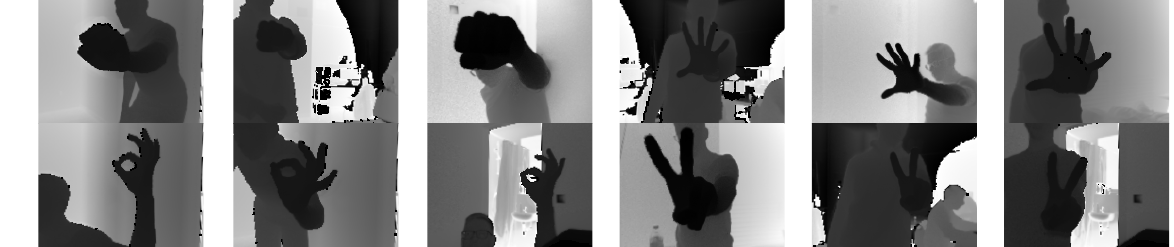
Figure 4. Depth images of gestures from left to right: Fist(0), Palm(1), Rabbit(2), Victoria(3).